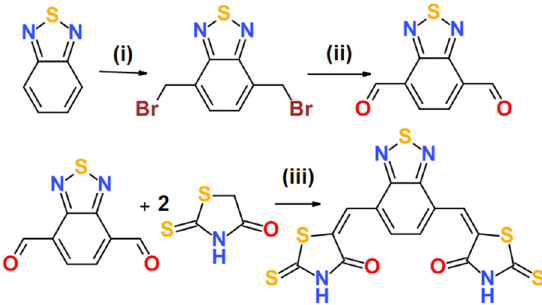
Scheme 1. Reaction scheme for the synthesis of